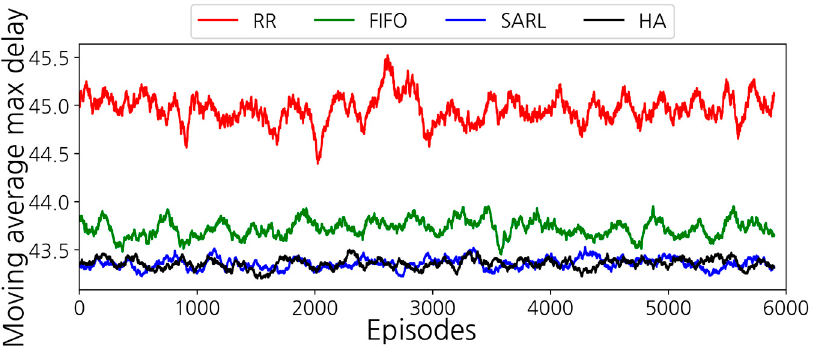
Figure 19. Moving average of maximum E2E latency per scheduler when random flows are generated in topology